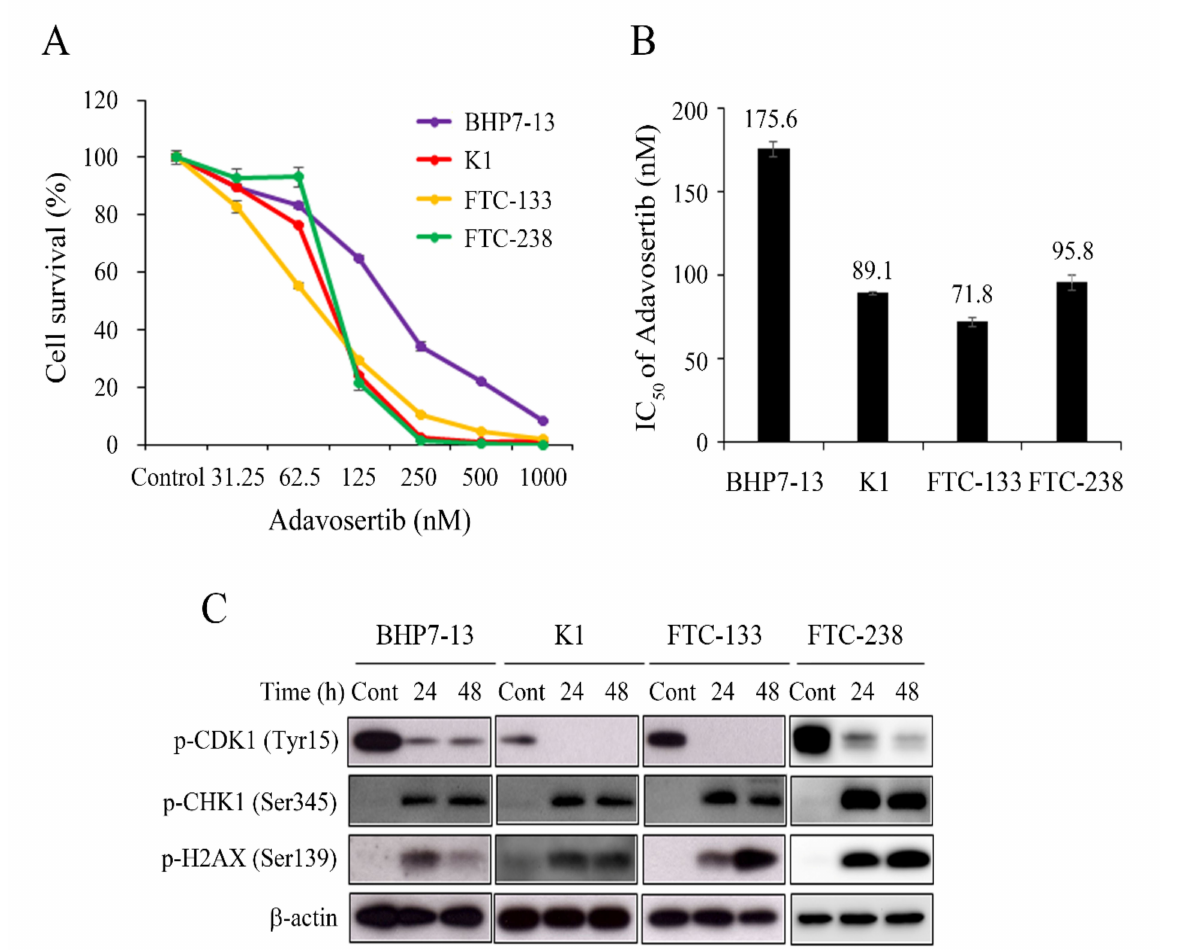
Figure 1. Adavosertib treatment induces dose-dependent cytotoxicity in four DTC cell lines. ( A ) Dose-response curves were obtained from cells treated with adavosertib for a 4-day treatment course in four DTC cell lines. ( B ) The median-effect dose (IC 50 ) of adavosertib on day 4 was determined by CompuSyn software for each cell line. ( C ) DTC cells were treated with vehicle or adavosertib (500 nmol/L) for 24 and 48 h, after which immunoblotting was performed to determine the expression of p-CDK1 (Tyr15), p-CHK1 (Ser345), and p-H2AX (Ser139). p-CDK1 (Tyr15) expression was decreased, and p-CHK1 (Ser345) and p-H2AX (Ser139) expression was increased by adavosertib in the four cell